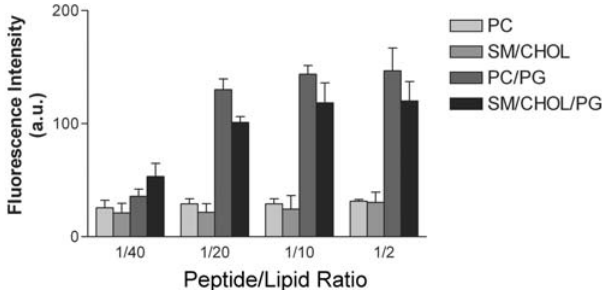
Figure 1. Penetratin binding to LUV. Penetratin binding was followed by detection of tryptophan fluorescence in LUV recovered after centrifugation. Penetratin concentration varied and LUV concen- tration was maintained constant. Peptide/Lipid ratio is given by weight. In the absence of membranes, no fluorescence was recovered after centrifugation. SM/Chol (1/1), PC/PG (9/1), SM/Chol/PG (4/5/1). (a.u.); arbitrary units. Mean of three independent